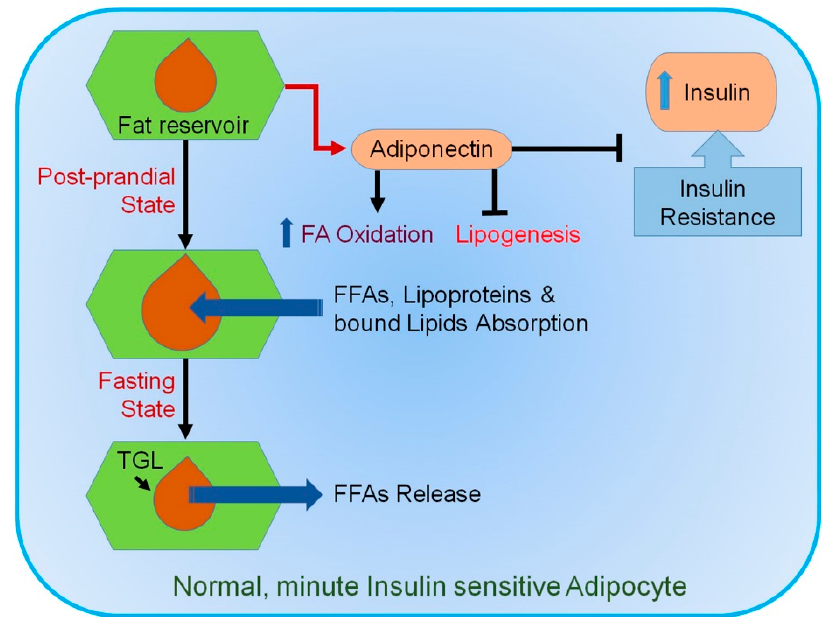
Figure 1. Mechanism involved in normal healthy adipocytes. In response to a sedentary lifestyle, food intake, and an increase in circulating insulin, small healthy adipocytes absorb different types of lipids. They tend to suppress lipogenesis and secrete adiponectin (ADP). ADP promotes insulin sensitivity and fatty acid (FA) oxidation. During fasting, triglyceride lipases (TGLs) become activated, releasing free fatty acids (FFAs). Blue upward arrow indicates an increase. FFAs play a vital role in the development of obesity-associated metabolic disorders.